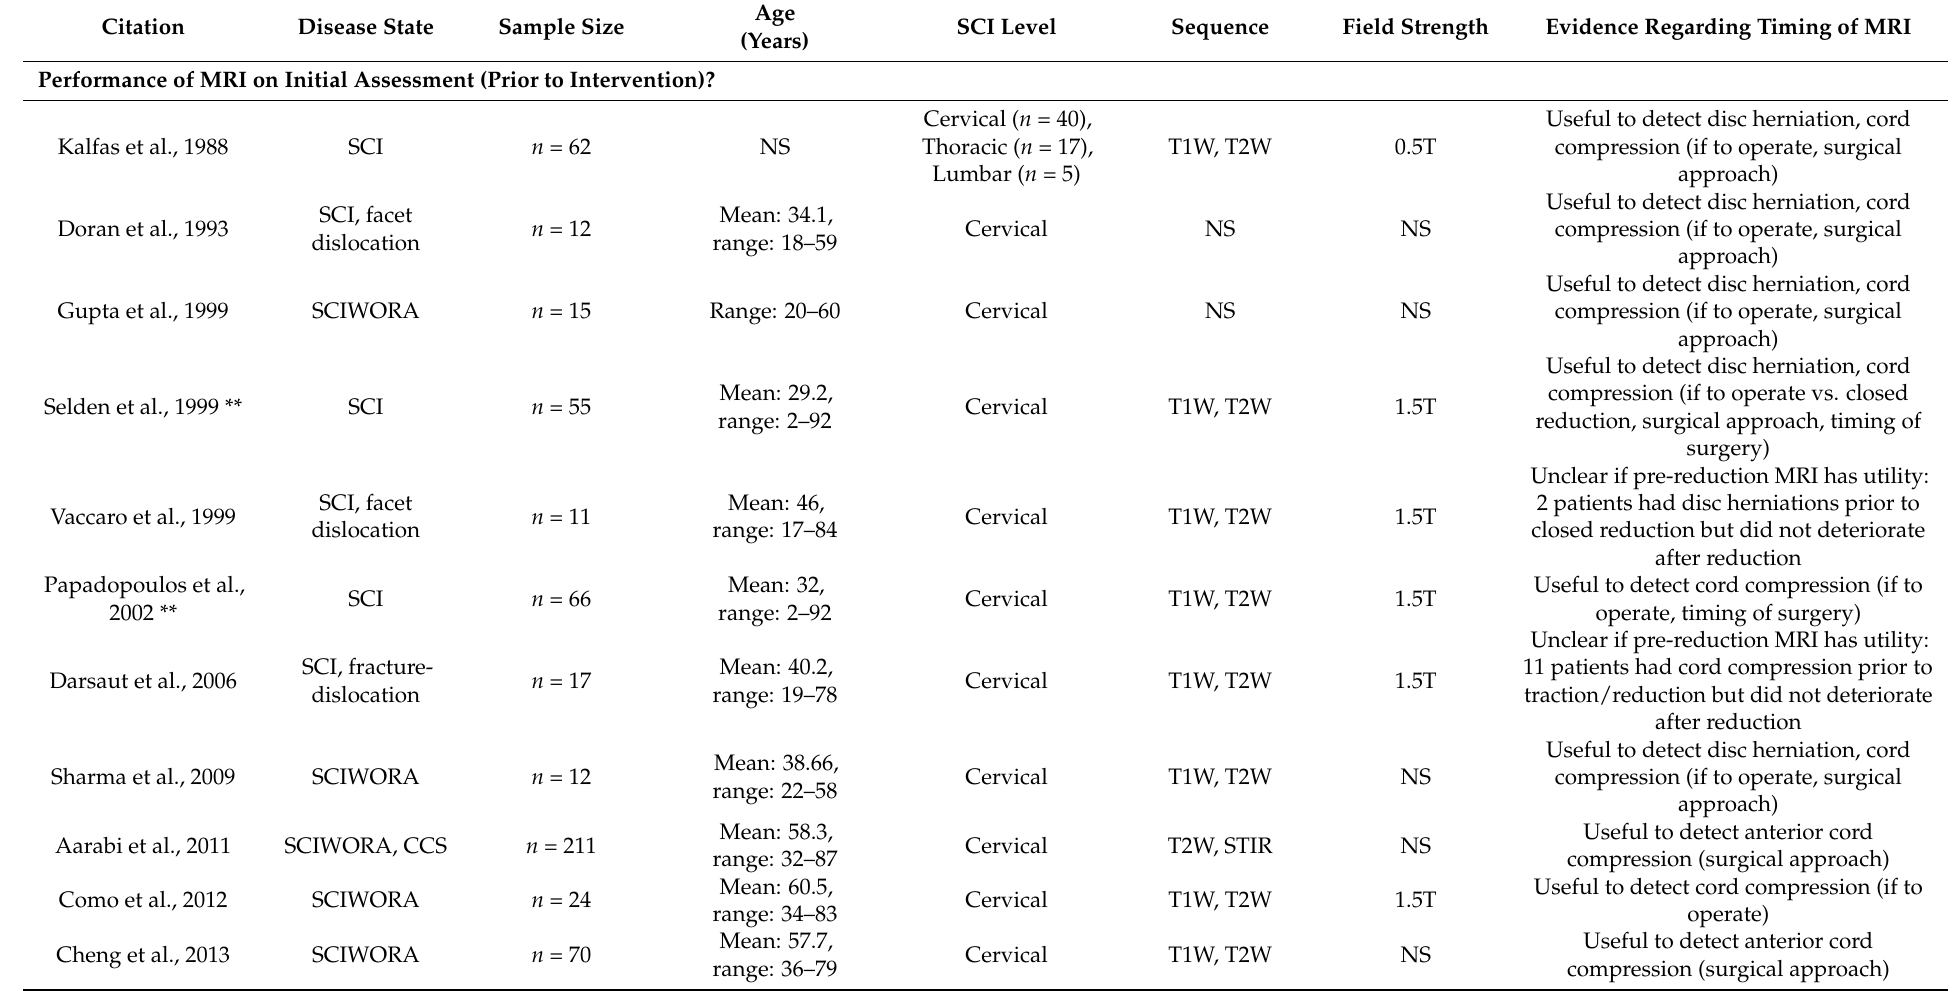
Table 6. Key Question 4: When should MRI be performed in acute spinal cord